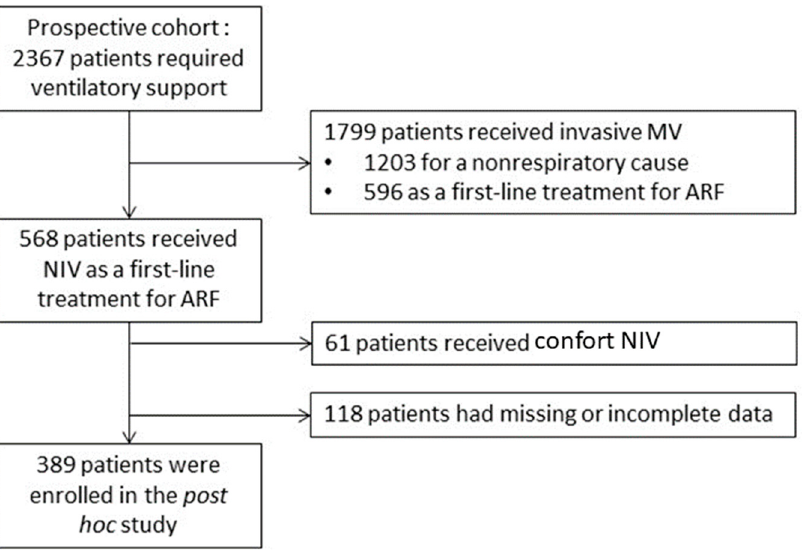
Figure 1. Flow chart of the study. MV, mechanical ventilation; ARF, acute respiratory failure; NIV, non-invasive ventilation.